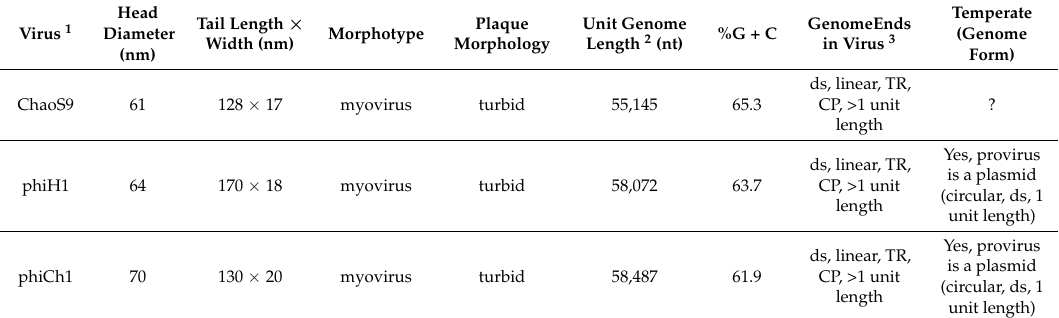
Figure 5. Genome map of ChaoS9 compared to phiCh1 and phiH1. ( a ) Cumulative AT-skew of all three viral genomes. ( b ) Genome map of phiCh1; ( c ) Genome map of ChaoS9; ( d ) Genome map of phiH1. Scale bar at bottom shows length, in kbp. Pink shading between genome maps indicates regions of similarity (tBLASTx, ≥ 30% amino acid identity). Functionally similar genes have been colored the same and are labeled nearby on one or more of the genomes (see Table 2 for details). The colors, gene labels (and encoded proteins) are: red, terL (large subunit terminase); light green, por (portal protein); brown, capsid protein genes, such as mcp , gpE and hp32 (major capsid protein), hp20, hp67, cp67; yellow, tpm (tape measure protein); blue, bpj (baseplate J family protein); pink, tail fiber genes; light purple, par (plasmid partition); dark green, orc1 , (replication protein Orc1); light blue, repH (plasmid replication protein); light grey, dcm5 , yhdJ , ycdA , m.II , m.III , m.I (methyltransferases); dark grey, ISH12 transposase; black, integrases ( int1 , int2 ). Genes of unknown or uncertain function are uncolored (white). The L-region of phiH1 has been described by [41]. Table 1. Characteristics of ChaoS9 and related haloviruses phiH1 and